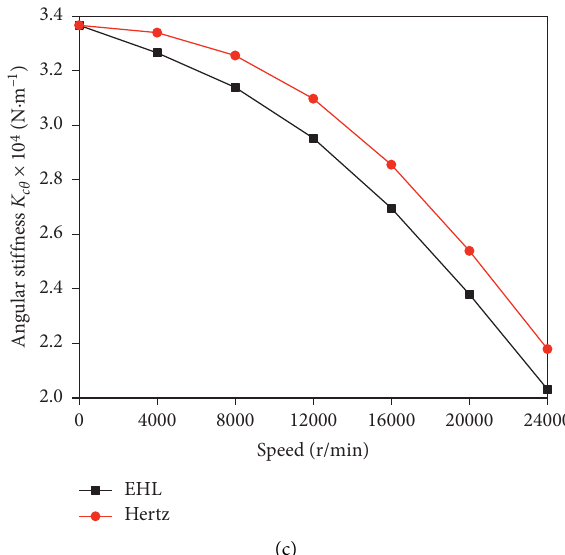
Figure 18: Influences of the speed and EHL on contact stiffness. (a) Radial stiffness. (b) Axial stiffness. (c) Angular